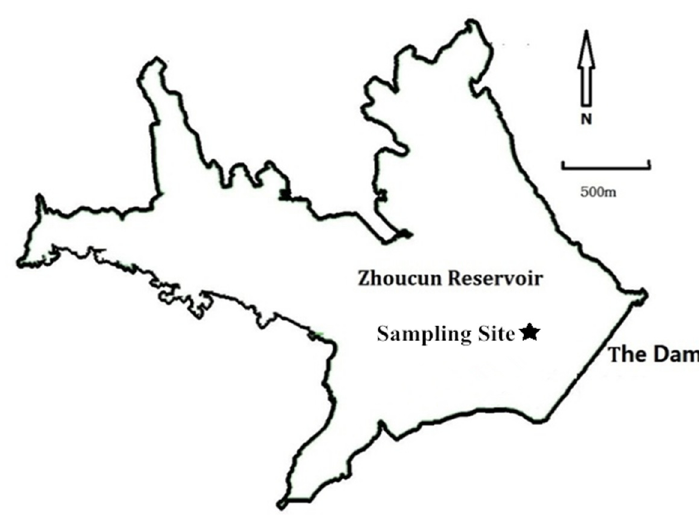
Figure 1. Bathymetric map of Zhoucun reservoir with location of sampling site.